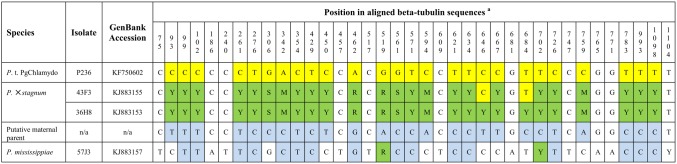
Beta-tubulin sequence alignment of Phytophthora ×stagnum, P. mississippiae and P. taxon PgChlamydo.Position numbers are given based on the alignment. Shading color: green indicates ambiguous sequences of polymorphic positions; yellow indicates sequences of the paternal parent P. taxon PgChlamydo; blue indicates sequences of the putative maternal parent. aY = T and C; S = G and C; M = A and C; R = G and A.